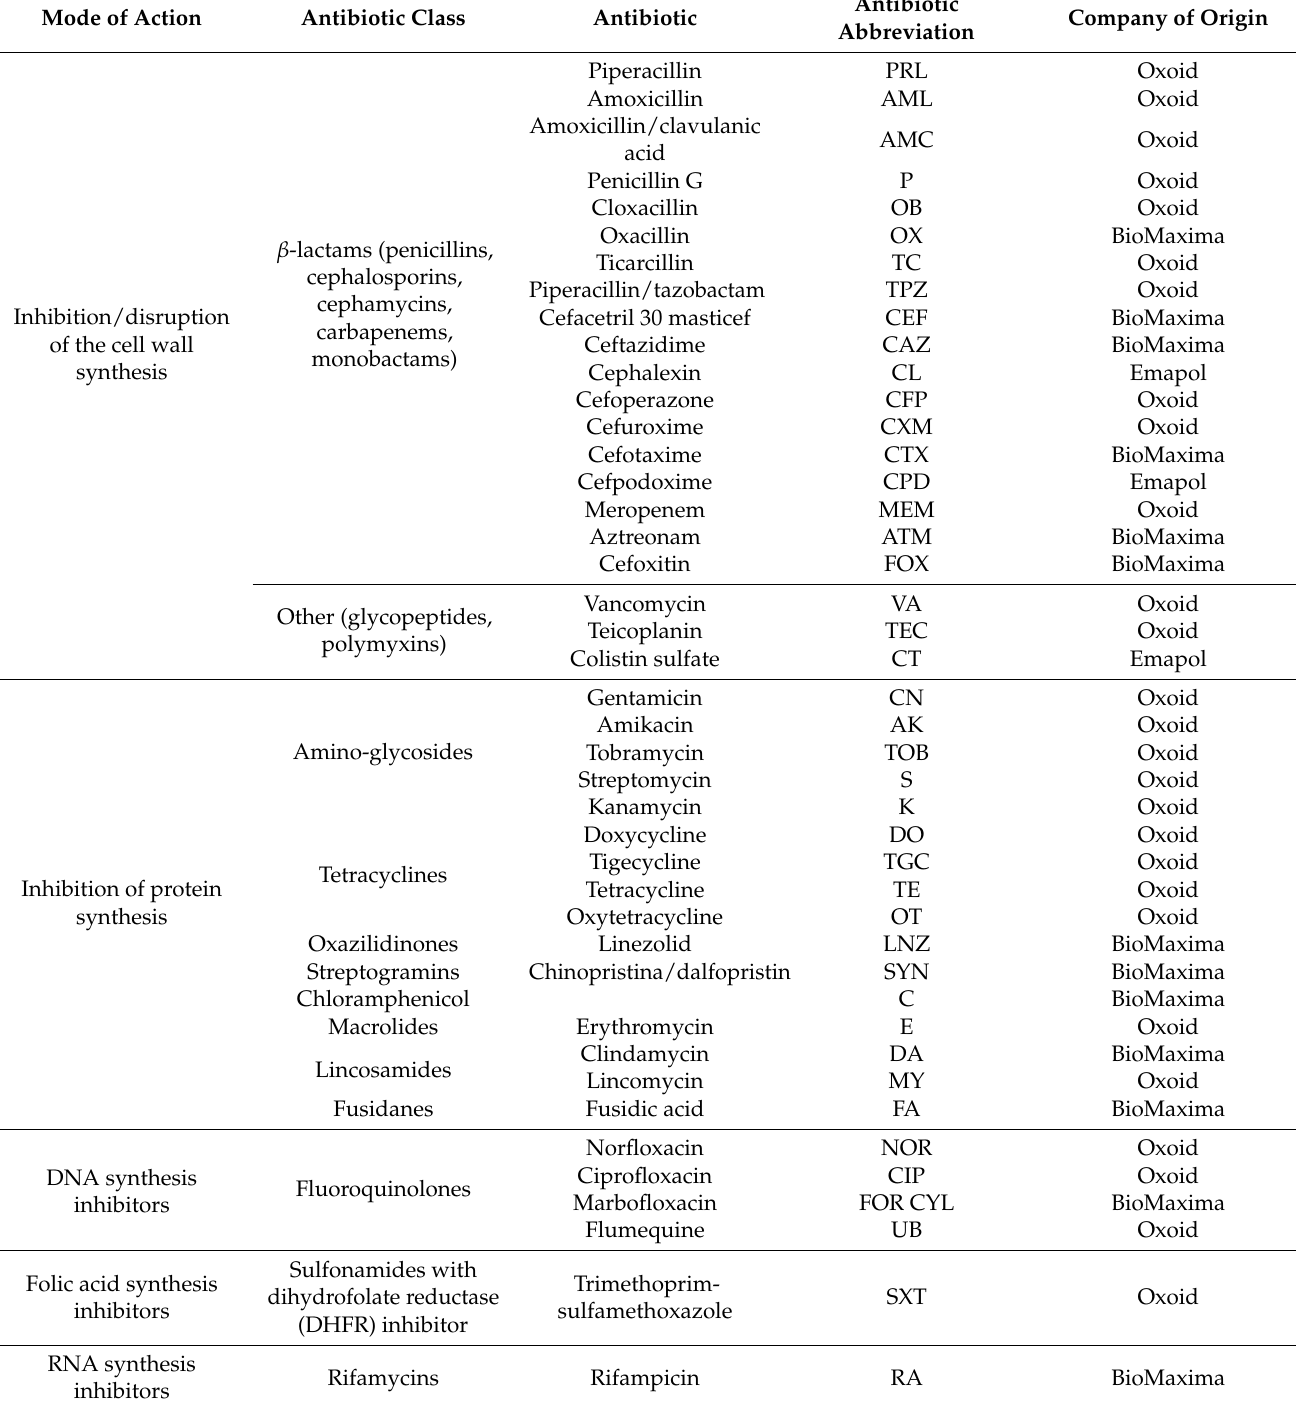
Table 2. Antibiotics used in the PAS effect presence